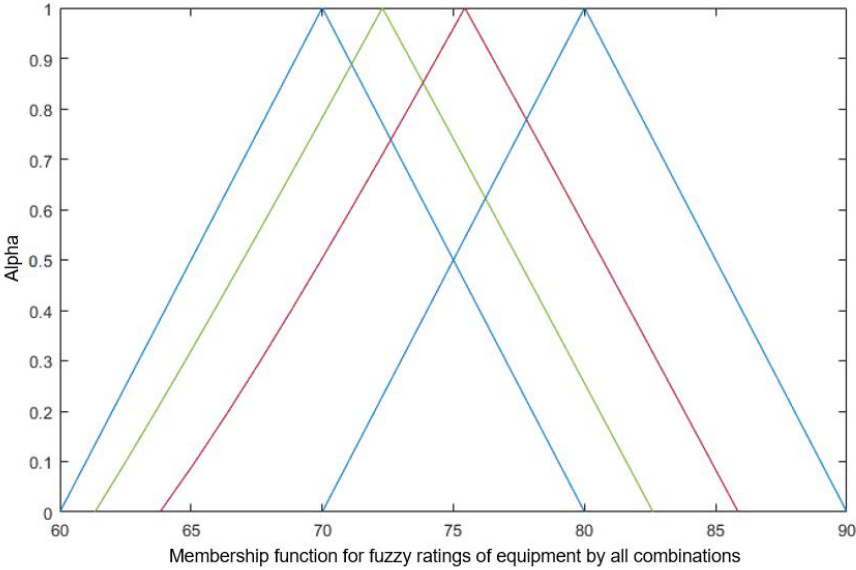
Figure 10. Graphical representation of the equipment component rating values for all combinations. The final fuzzy value of the equipment component rating is shown in Table 13 with the lower and upper boundaries of the α -cuts, and in Figure 11, a graphical representation of the membership function with all α -cuts is